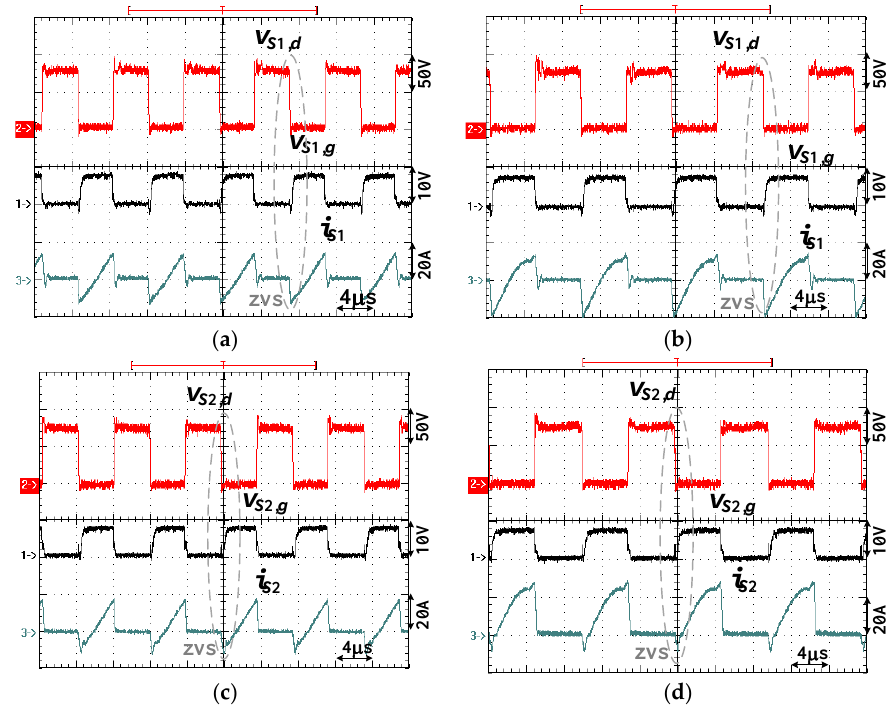
Figure 9. Experimental results of power switches S 1 and S 2 under low voltage mode operation and V in = 39 V: ( a ) v S 1 , g , v S 1 , d , i S 1 at 20% rated power; ( b ) v S 1 , g , v S 1 , d , i S 1 at 100% power; ( c ) v S 2 , g , v S 2 , d , i S 2 at 20% rated power; ( d ) v S 2 , g , v S 2 , d , i S 2 at 100% power.